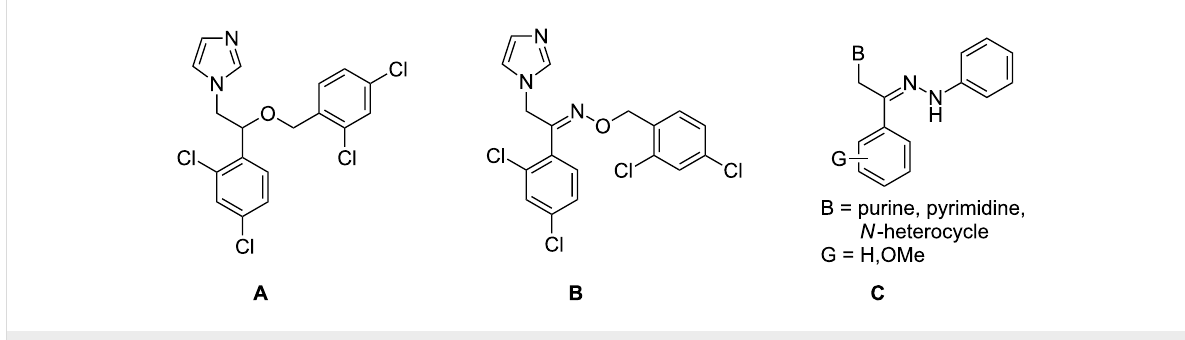
Figure 1: Chemical structures of miconazole ( A ), oxiconazole ( B ) and hydrazono acyclic nucleoside analogue ( C ).